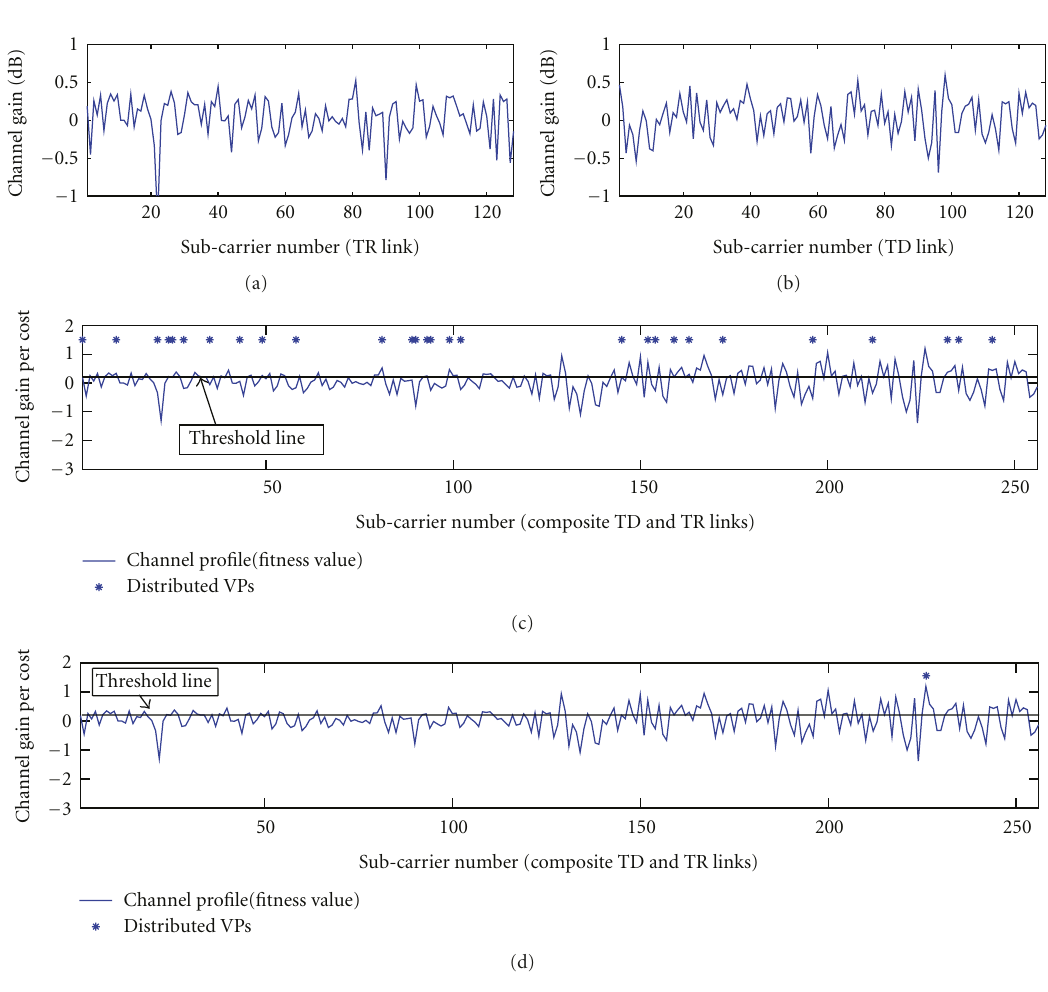
Figure 6: Snapshot of channel profile for N = 128 in the (a) TR link and (b) TD link and channel gain per cost profile (length of 2 N ) with 30 randomly distributed VPs (c) before convergence and (d) after